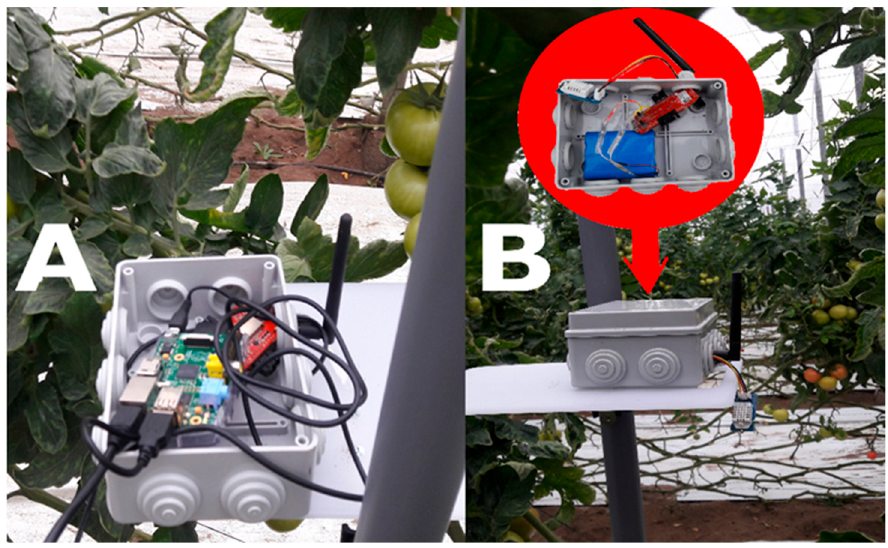
Figure 2 . Wireless sensor networks (WSN) nodes. ( A ) Sink node connected to the Raspberry Pi. ( B ) Sensor node powered by an external lithium